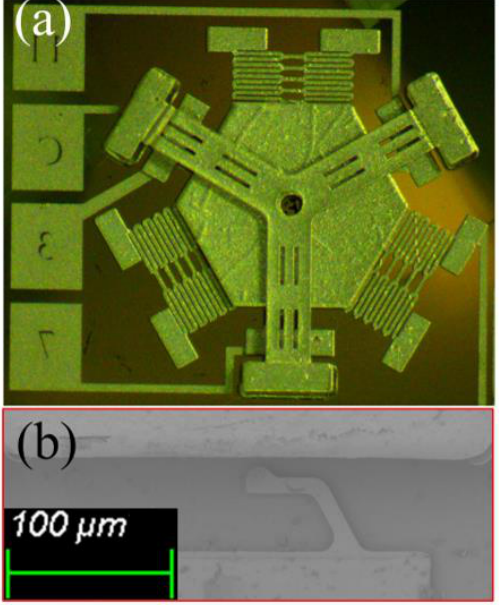
Figure 12. The photos of prototype. ( a ) the complete structure drawing of fabricated inertial switch, ( b ) the elastic fixed electrode.